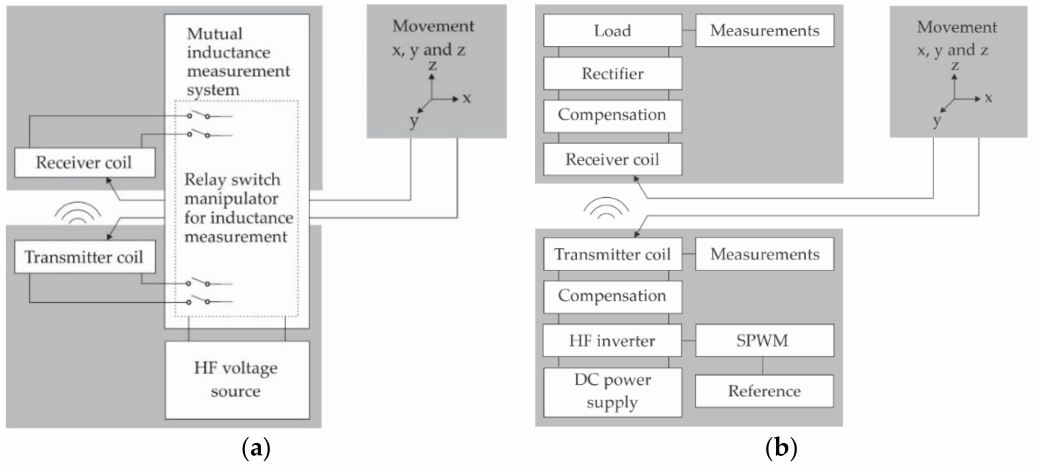
Figure 4. Block diagram of: ( a ) the coupling coefficient measurement system; ( b ) the IPT